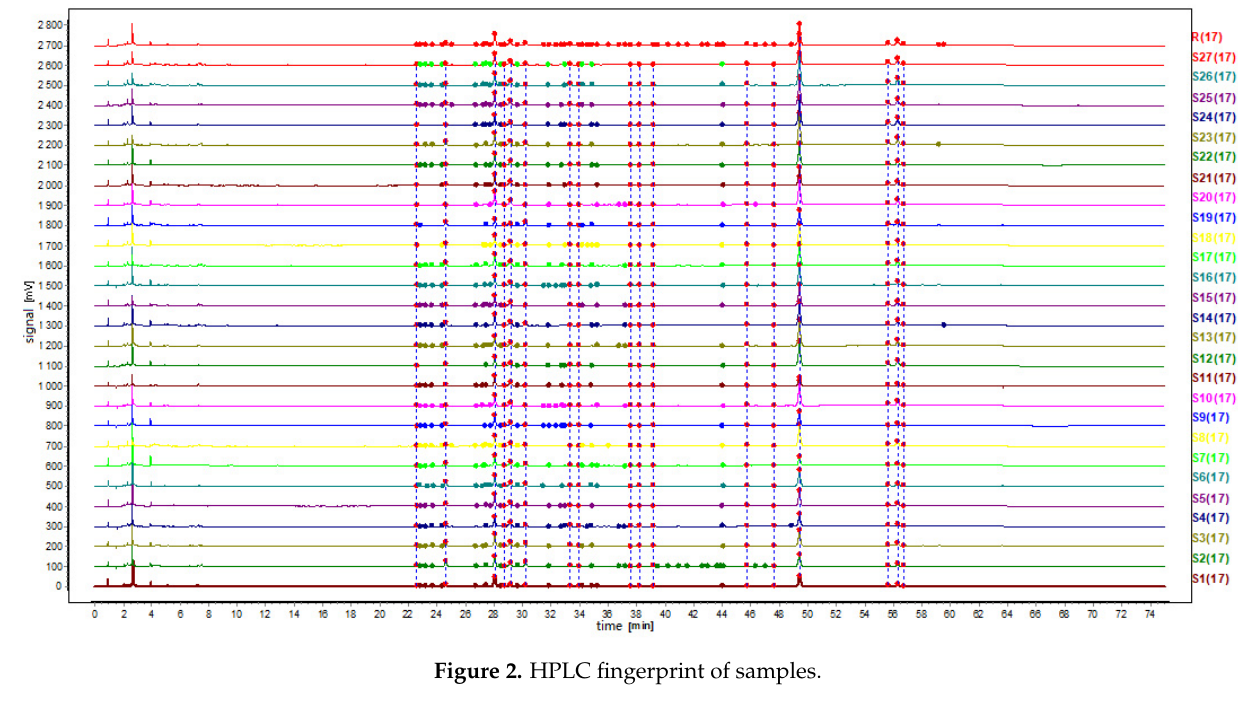
Figure 2. HPLC fingerprint of samples.